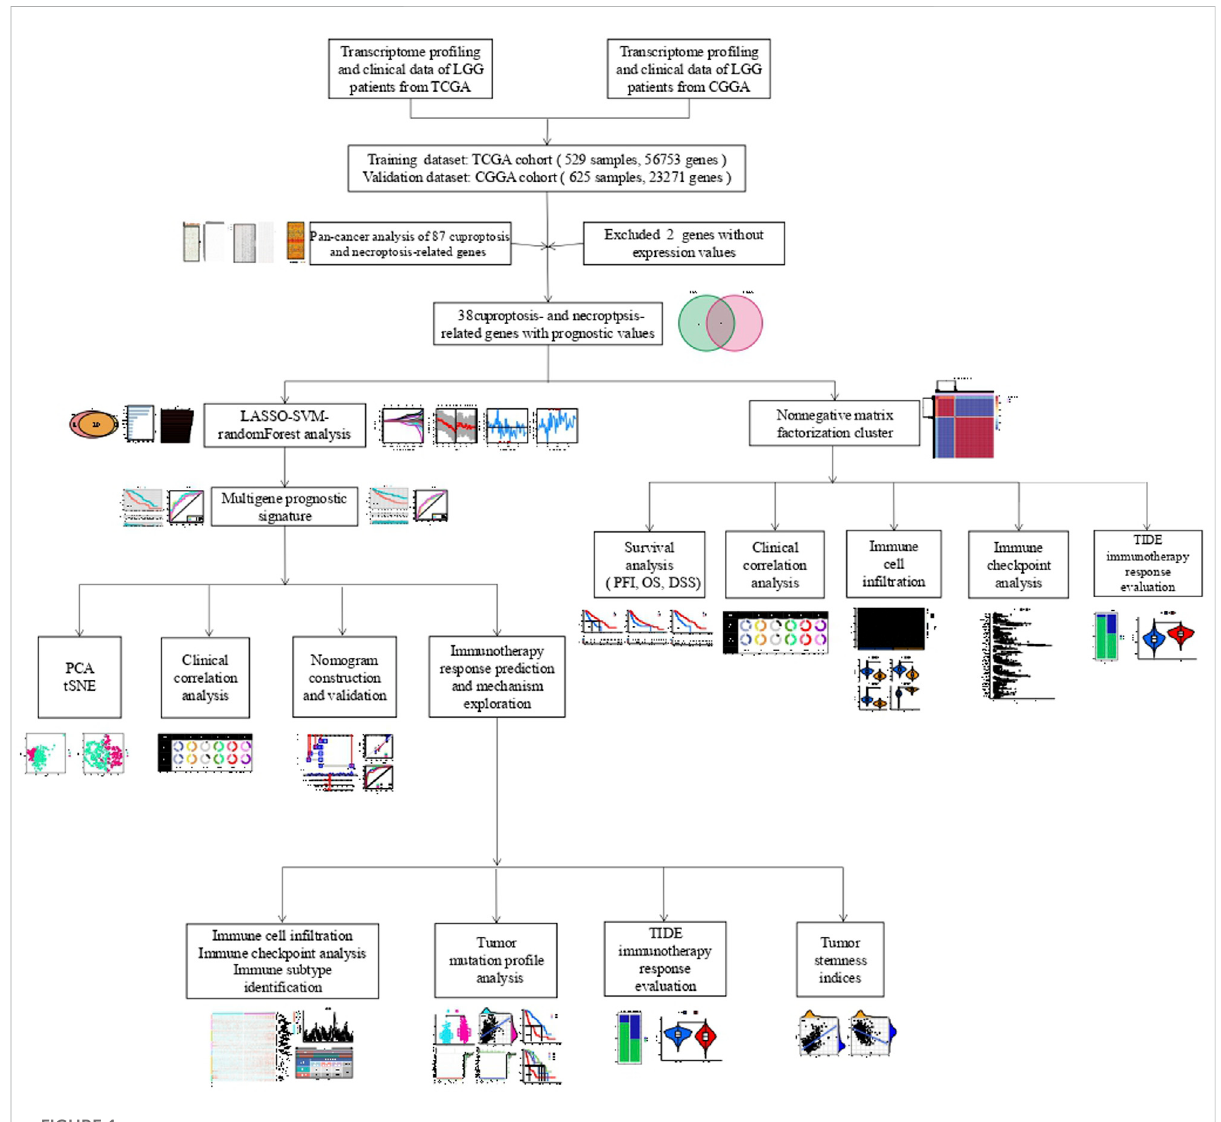
FIGURE 1 The fl ow chart of this